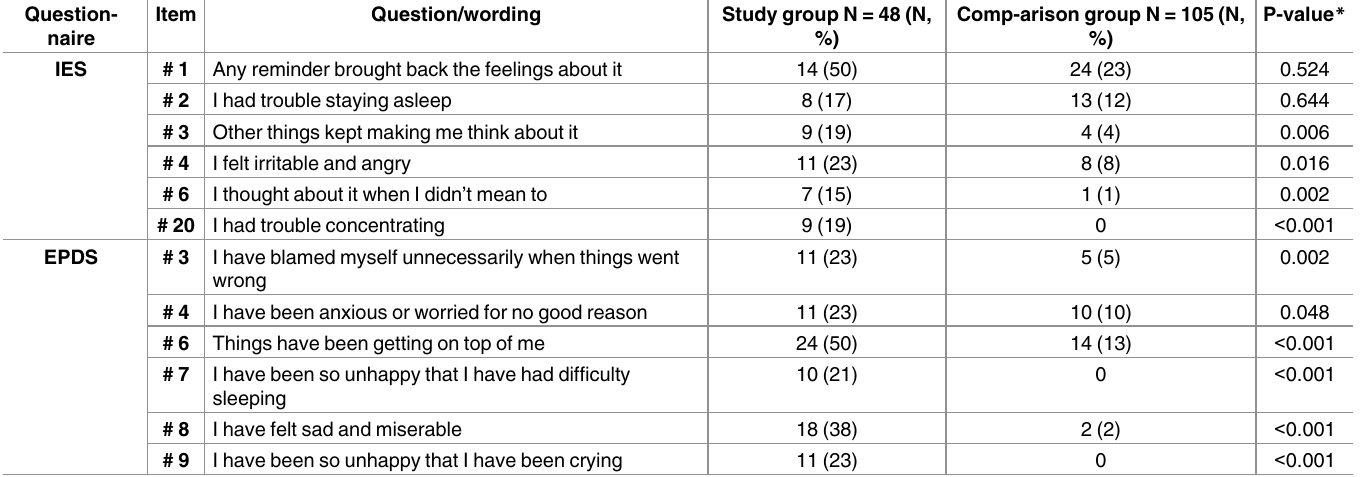
Abbreviations: IES Impact of Event Scale, EPDS Edinburgh Postnatal Depression